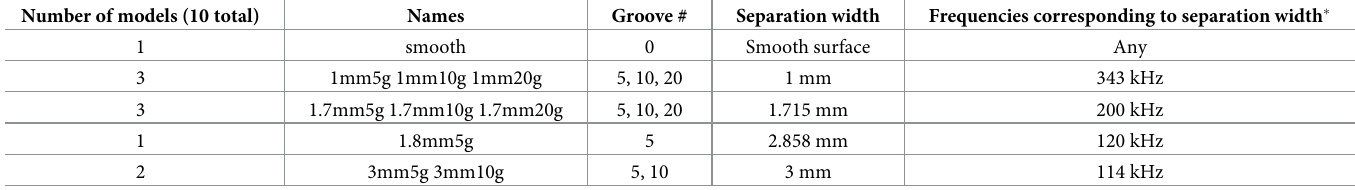
Table 1. Ten different pinna model configurations were